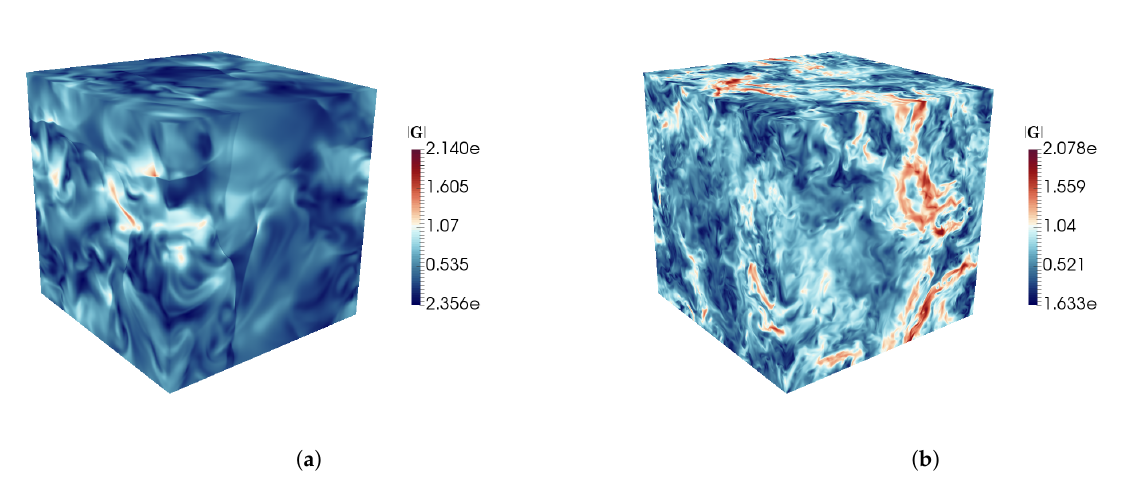
Figure 2. Momentum magnitude